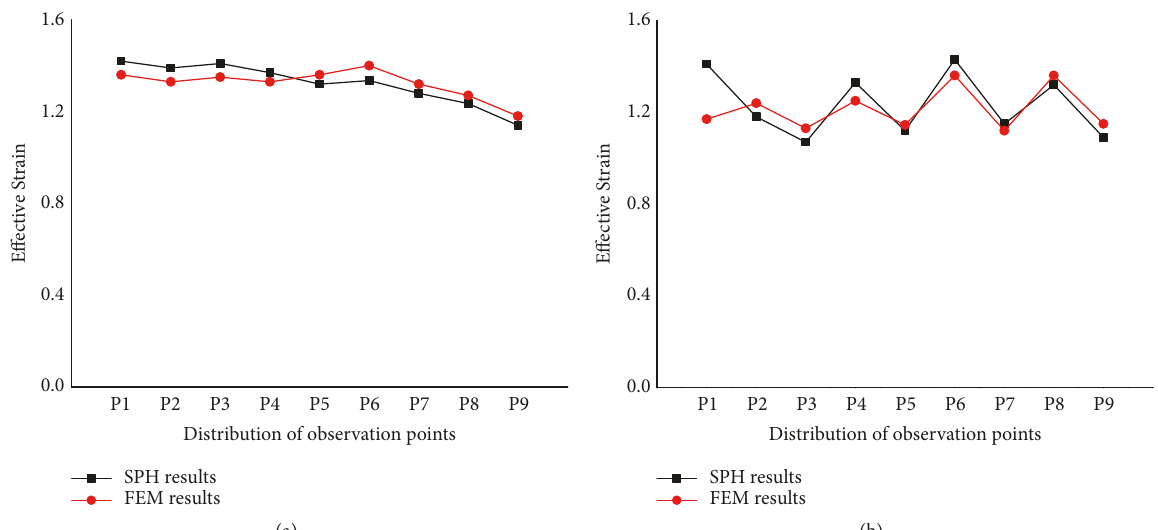
Figure 17:Comparison of equivalentstrain curves.(a) Specimencanned with industrial pure iron. (b) Specimencanned with 2024aluminum alloy.